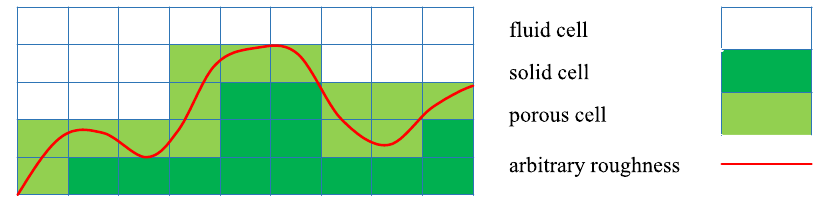
Figure 7. Cell type definition in the discrete porosity method. Both solid as well as porous cells build the roughness